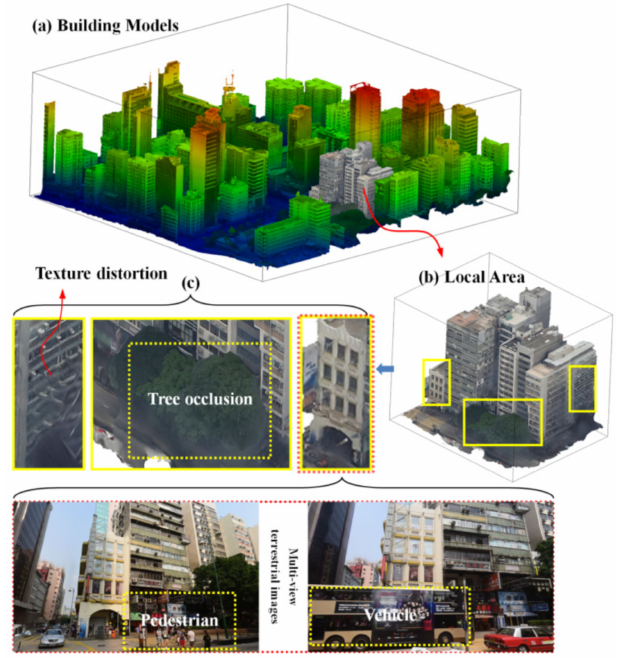
Figure 1. Objection occlusion and texture distortion in building models. ( a ) Example of CityGML building models; ( b ) building models of a local area; ( c ) object occlusion, e.g., tree, pedestrian, and vehicle. Yellow boxes with solid line indicate texture distortion of local areas caused by object occlusion in aerial photogrammetry. Yellow boxes with dotted line indicate object occlusion, e.g., tree, pedestrian, and